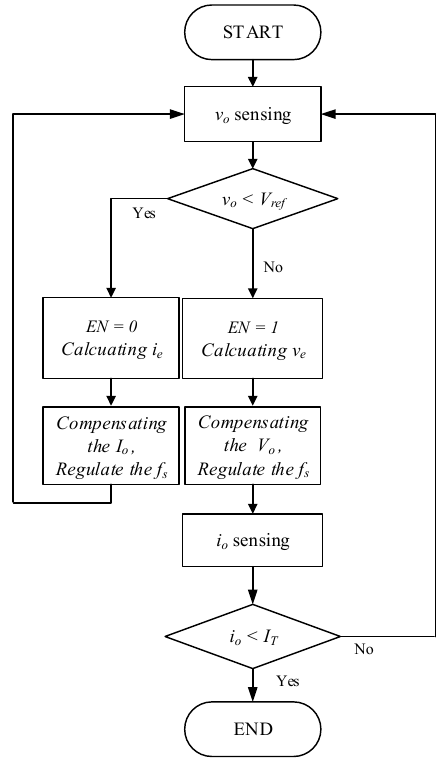
Figure 8. Operation principle of proposed compensator.